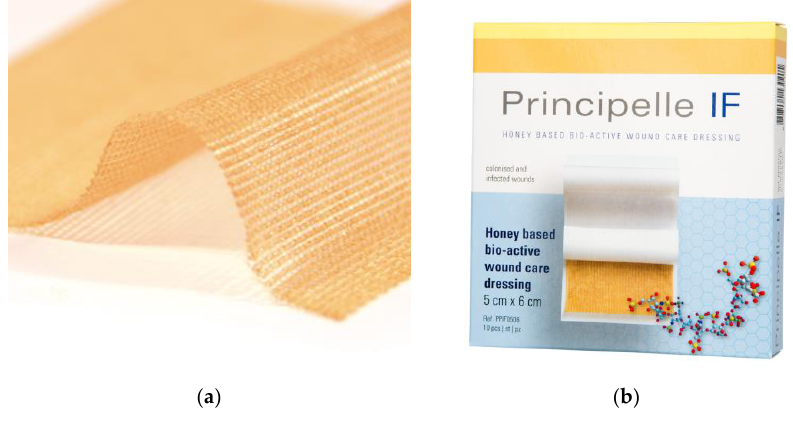
Figure 1. Examples of commercially available honey-based dressings for wound healing. ( a ) Acti- lite ® non-adherent viscose net dressing coated with 99% Manuka honey and 1% Manuka oil. © Image courtesy of Brightwake Ltd. (trading as Advancis Medical); ( b ) Principelle IF ® Honey based bio-active wound care dressing containing medical grade dark buckwheat honey with no syn- thetic components. © Image courtesy of Principelle B.V.